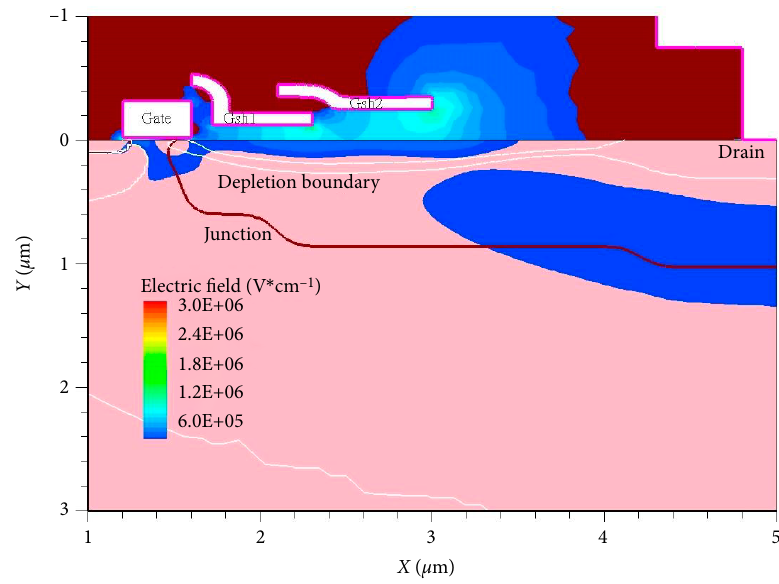
Figure 4: Electric field distribution at HCI tested condition.